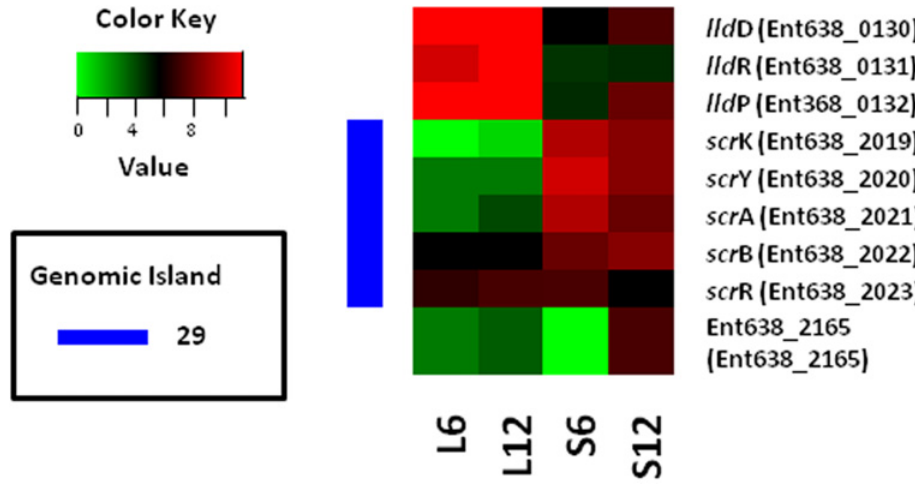
Figure 2. Expression levels of Enterobacter sp. 638 genes directly involved in sucrose and lactate metabolisms. Log 2 of normalized gene expression values (RPKM) are plotted for each condition. L6, L12, S6 and S12 represent the condition lactate and sucrose after 6 and 12 hours growth, respectively. Ent638_2165 is a hypothetical gene that showed homology to ycjM , a putative sucrose